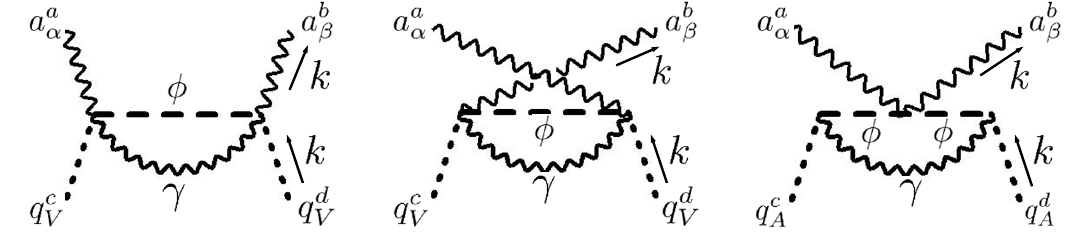
Figure 5 . Contributions from photon loops without a meson pole.